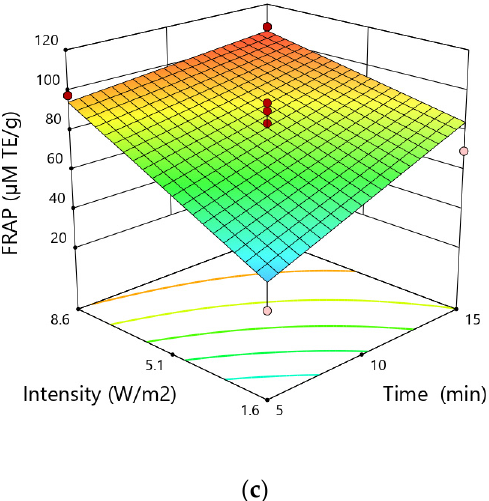
Figure 4. Response surfaces for the FRAP test ( μ M TE ∙ g − 1 ) in hemp extracts depending on the ( a ) time and size particle, ( b ) size particle and intensity, ( c ) intensity and time.